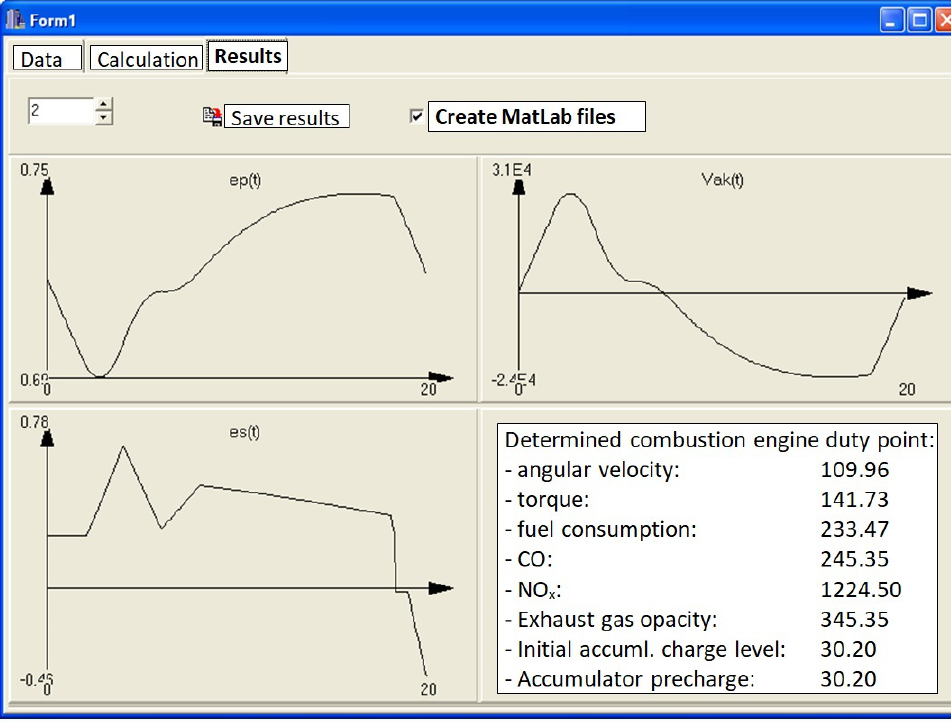
Figure 11. Graphic layout of software for computing multisource system control parameters, based on refined kinetostatic method [55].